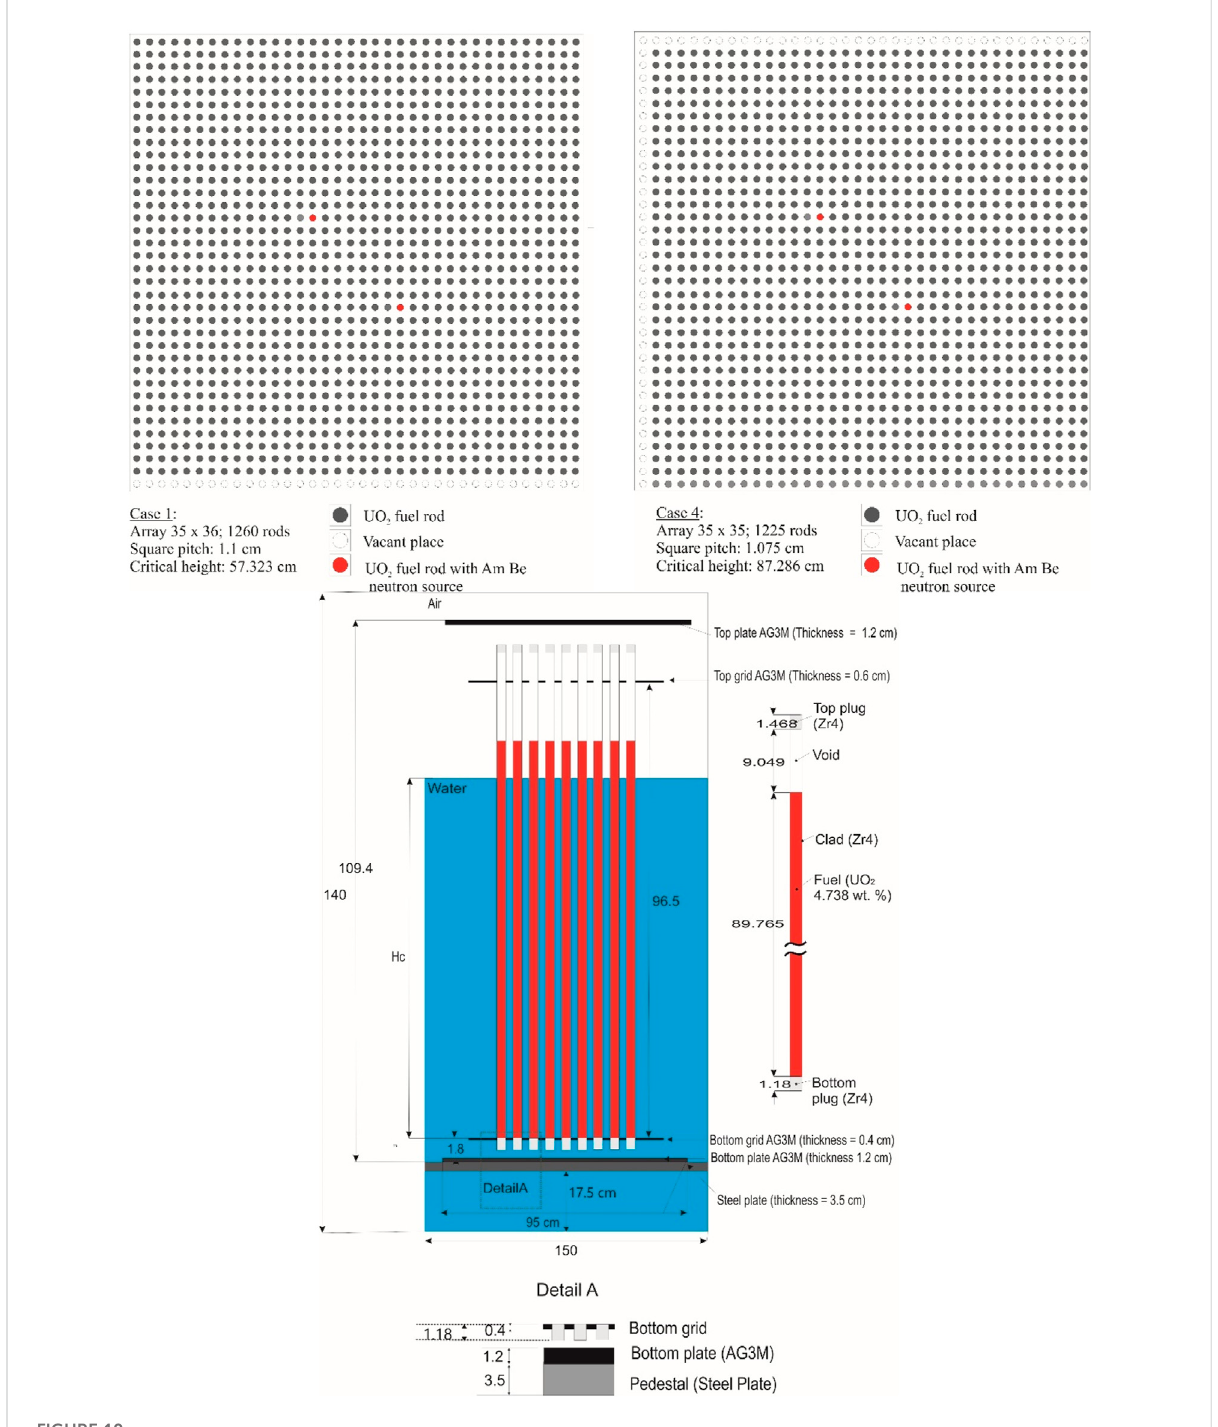
FIGURE 10 Horizontal and vertical cross-cut views of rod lattices (LEU-COMP-THERM-071).